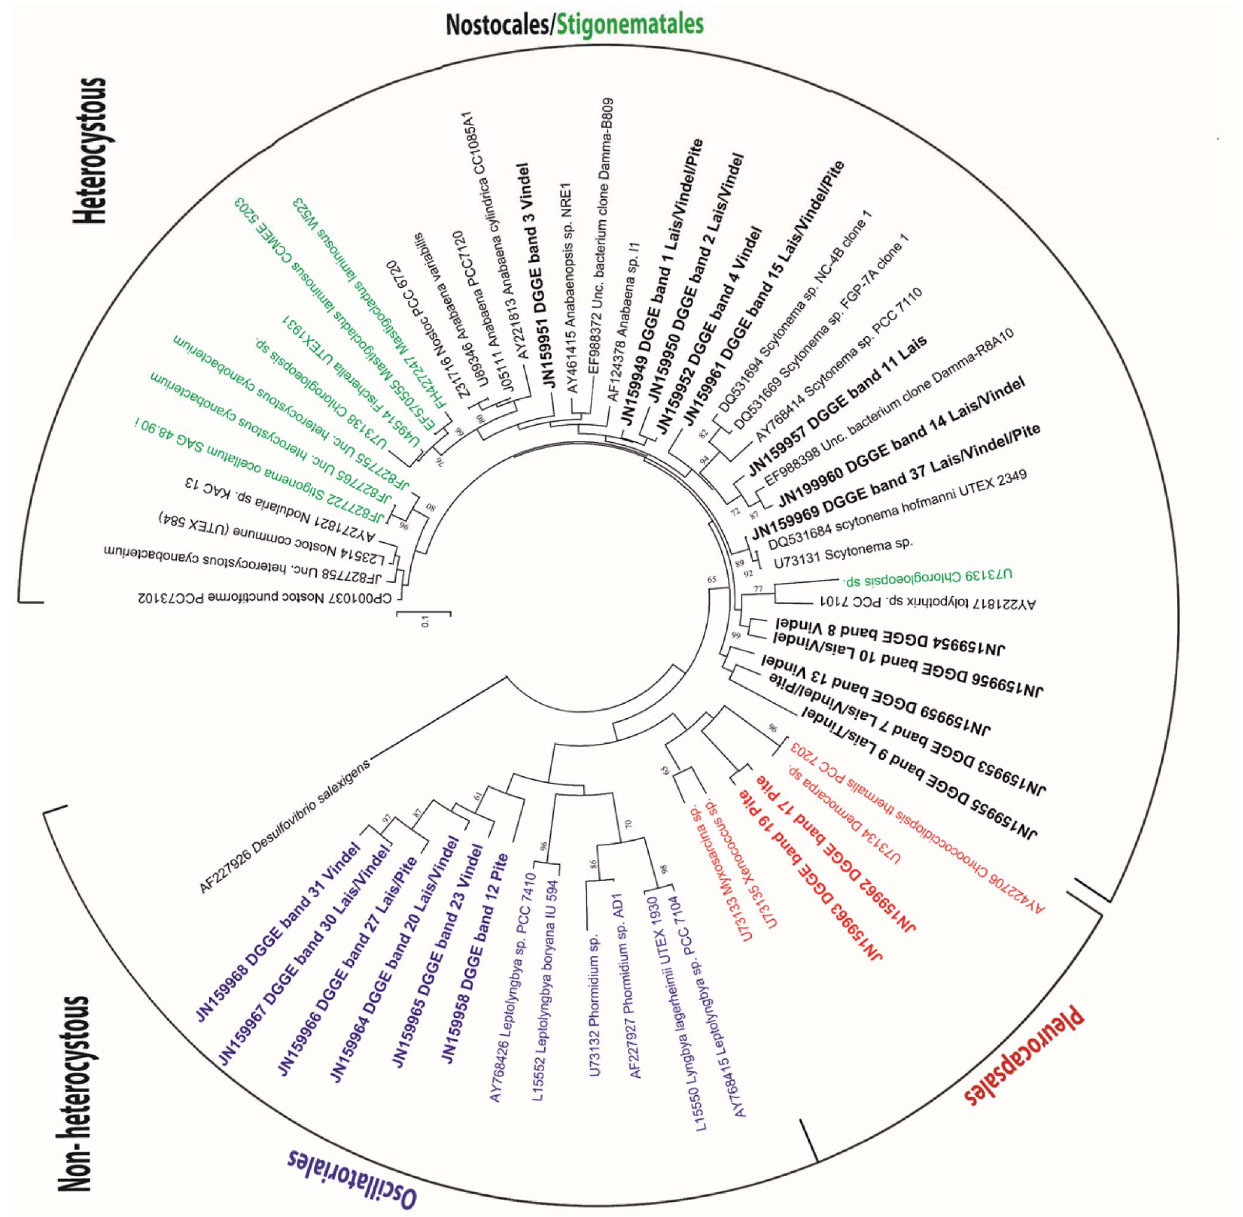
Figure 2. Phylogenetic affiliation of sequences retrieved using cyanobacterial specific nif H genes as targets combined with DGGE analyses of sediment associated DNA samples from wetland meadows along three major rivers (Vindel, Pite, and Lais) in northern Sweden. The phylogram was constructed using the maximum likelihood distance method with TrNIG model. Sequences obtained here are given in bold. Each DGGE band sequence is designated by their accession number, a code and the name of the river/s were it was collected. The numbers given at the nodes represent bootstrap values.